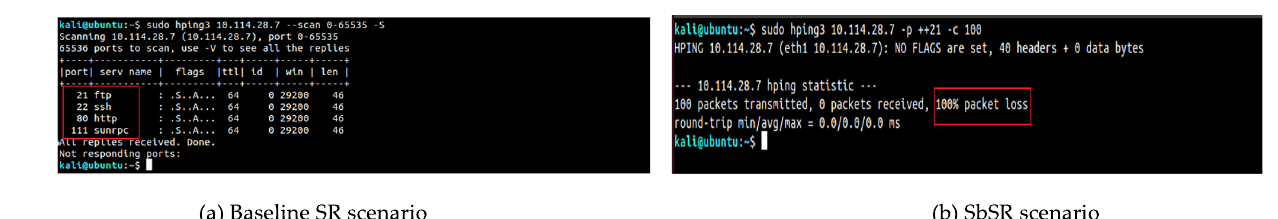
Figure 9. Experimental topology.